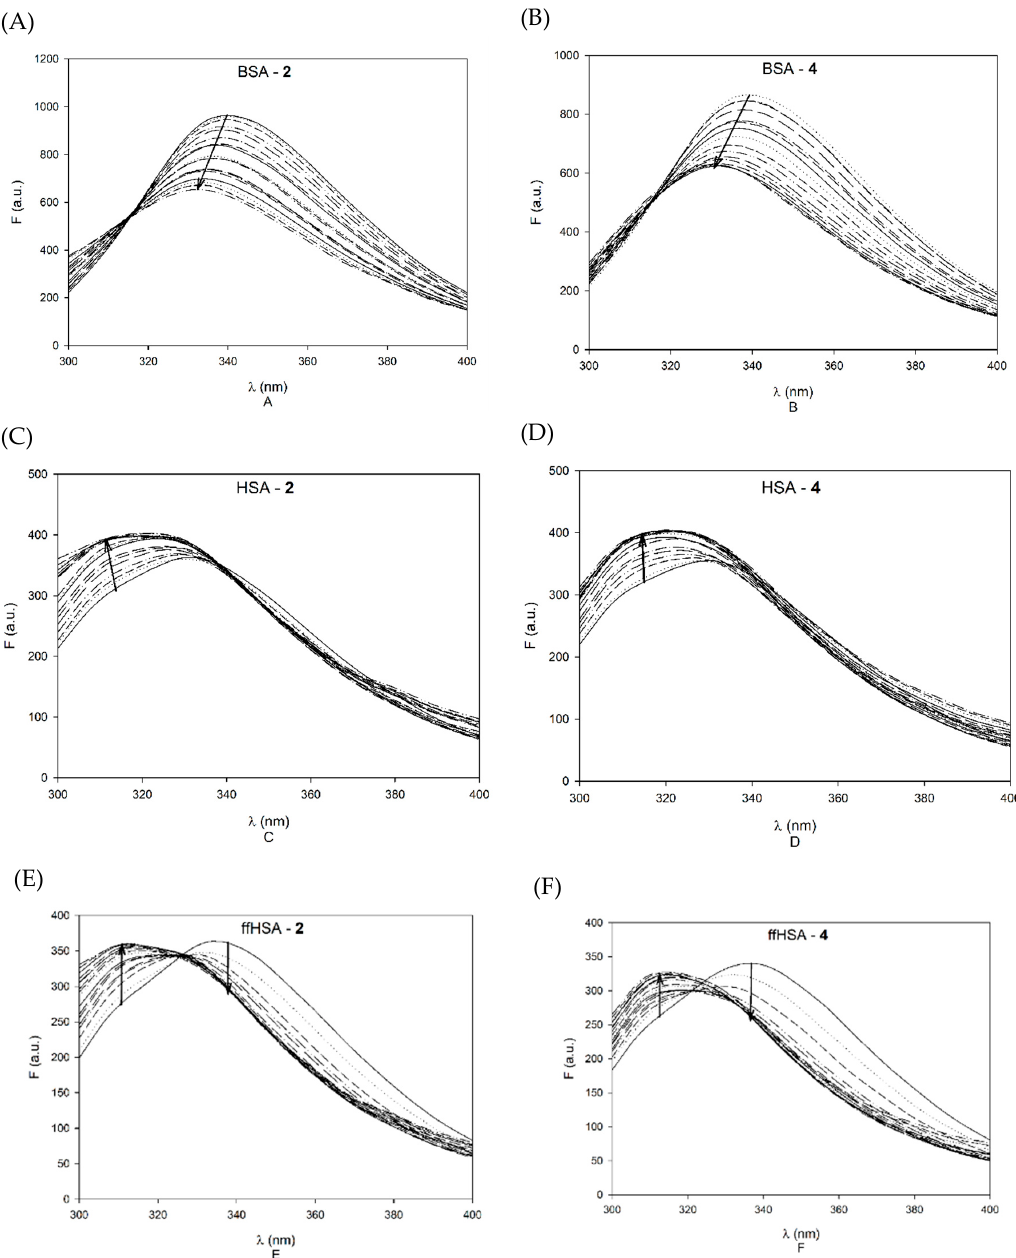
Figure 5. Emission spectra of 1 μ M BSA ( A and B ), HSA ( C and D ) and ffHSA ( E and F ) upon addition of increasing amounts of 2 and 4 . The final concentrations of diterpene were 5, 10, 20, 40, 60, 80, 100, 120, 140, 160, 180, 200, 250, 300, 350, 400, 450 and 500 μ M.